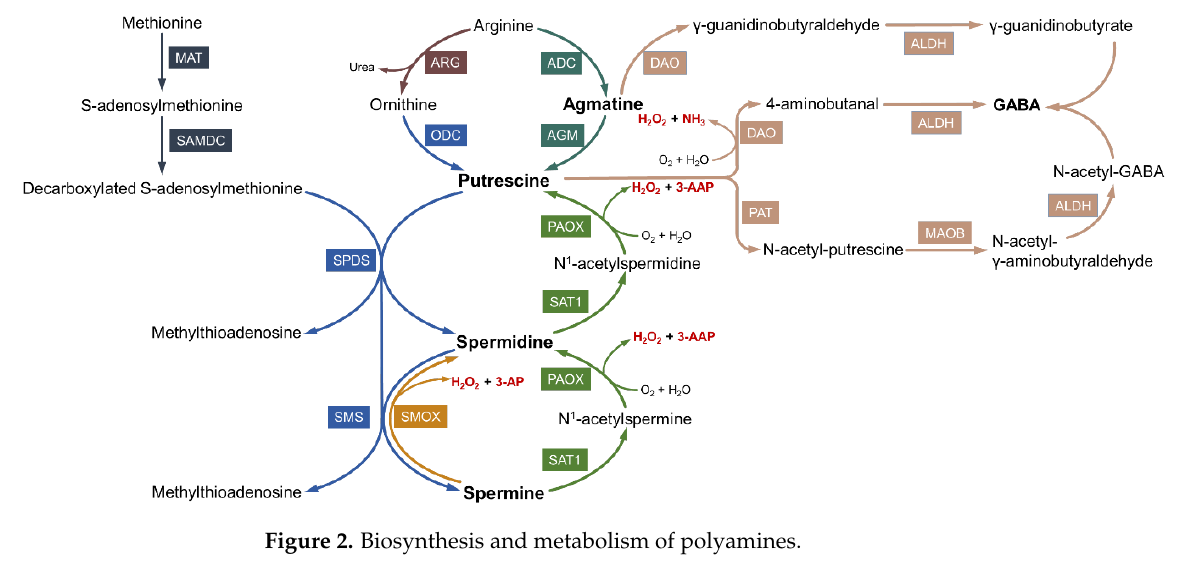
Figure 2. Biosynthesis and metabolism of polyamines.